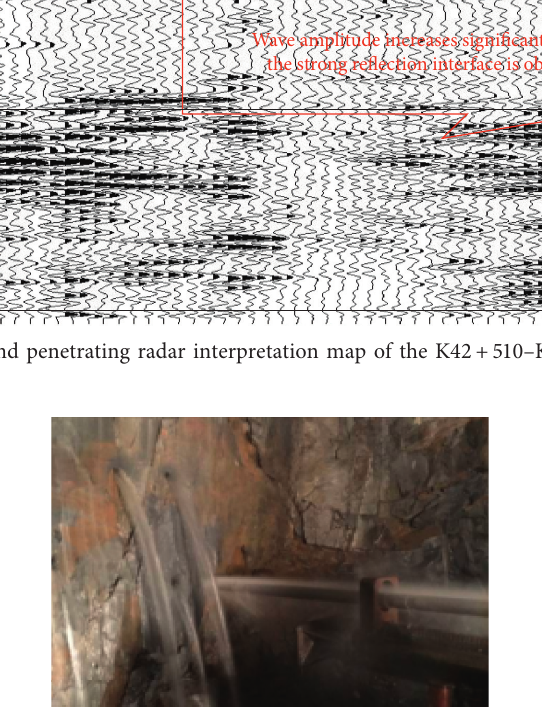
Wave amplitude increases significantly, and the strong reflection interface is obvious